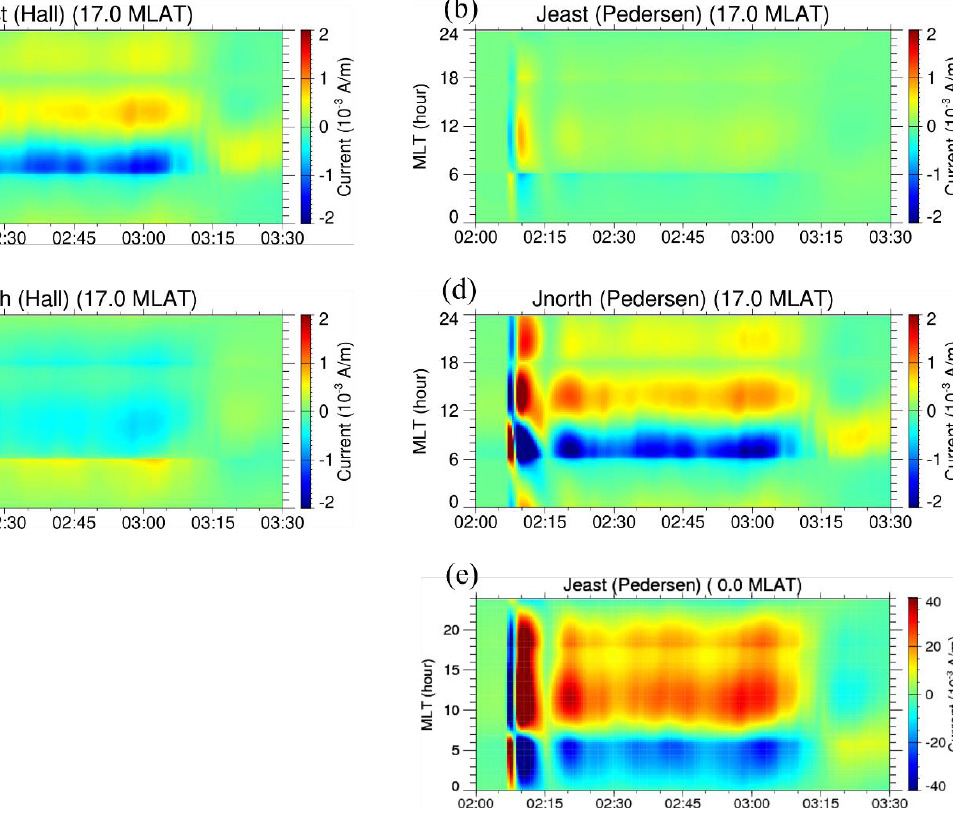
Figure 7. Ionospheric Hall and Pedersen currents at low latitude (17.0° MLAT), and the equatorial Pedersen (Cowling) current, reproduced by the REPPU global simulation model. (a)(b)(c)(d) are in the same format as (a)(b)(c)(d) in Figure 6. (e) is in the same format as (b).